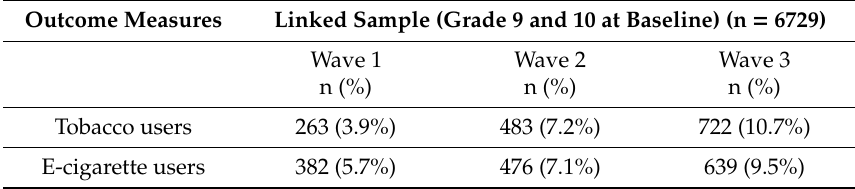
Table 2. Prevalence of current (past 30-day) tobacco users and tobacco users at each wave of the study, 2014–2017 COMPASS